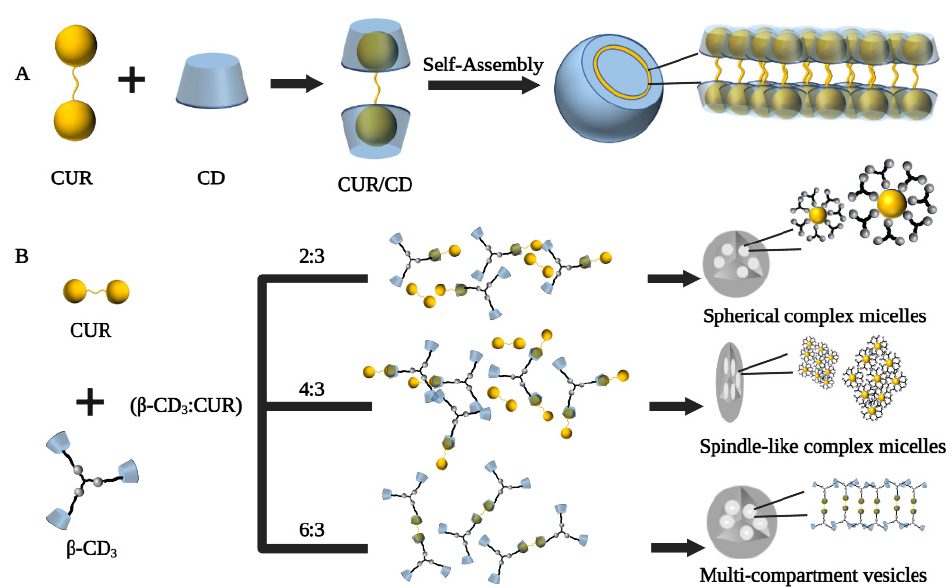
Figure 3. Preparation process of cyclodextrin self-assembled supramolecular networks. ( A ) Schematic diagram of the proposed mechanism of vesicle formation from CD and CUR [62]. ( B ) Schematic diagram of supramolecular self-assembly of three different shapes of curcumin/ β -cyclodextrin trimers [63].